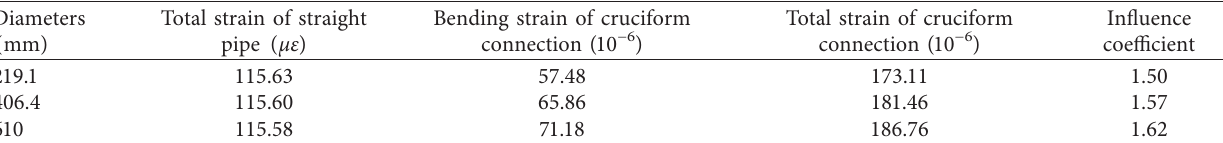
Table 8: Influence coefficients of cruciform connection with different